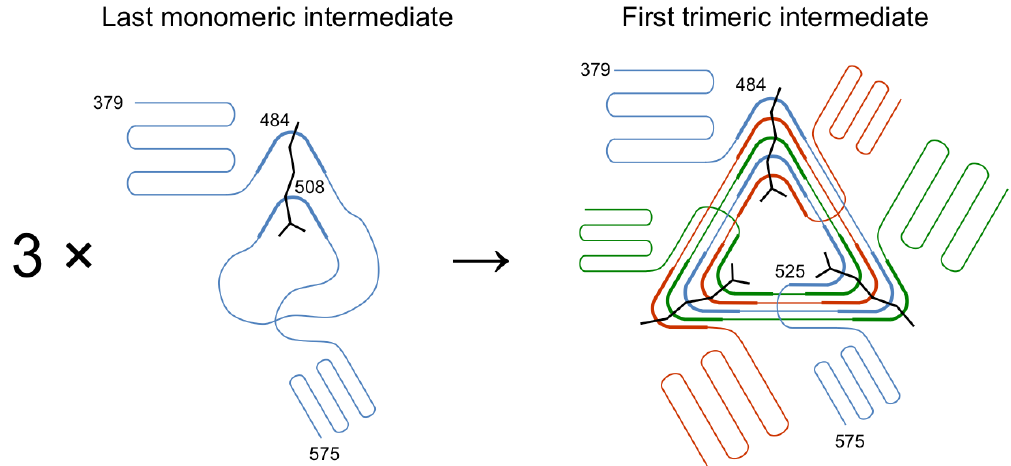
Figure 14. Trimerization of gp5 β -helix. Binding of a fatty acid (black) to a polypeptide chain (blue) promotes formation of a characteristic kink region (thicker line) and a corkscrew-like topology in a single chain. In the next step, fatty acids participate in the association of three chains into a trimer by facilitating the formation of kinks in other chains. Regions with a zigzag-like β -sheet topology are formed independently of the presence of fatty acids. Residue numbers are given for strategic